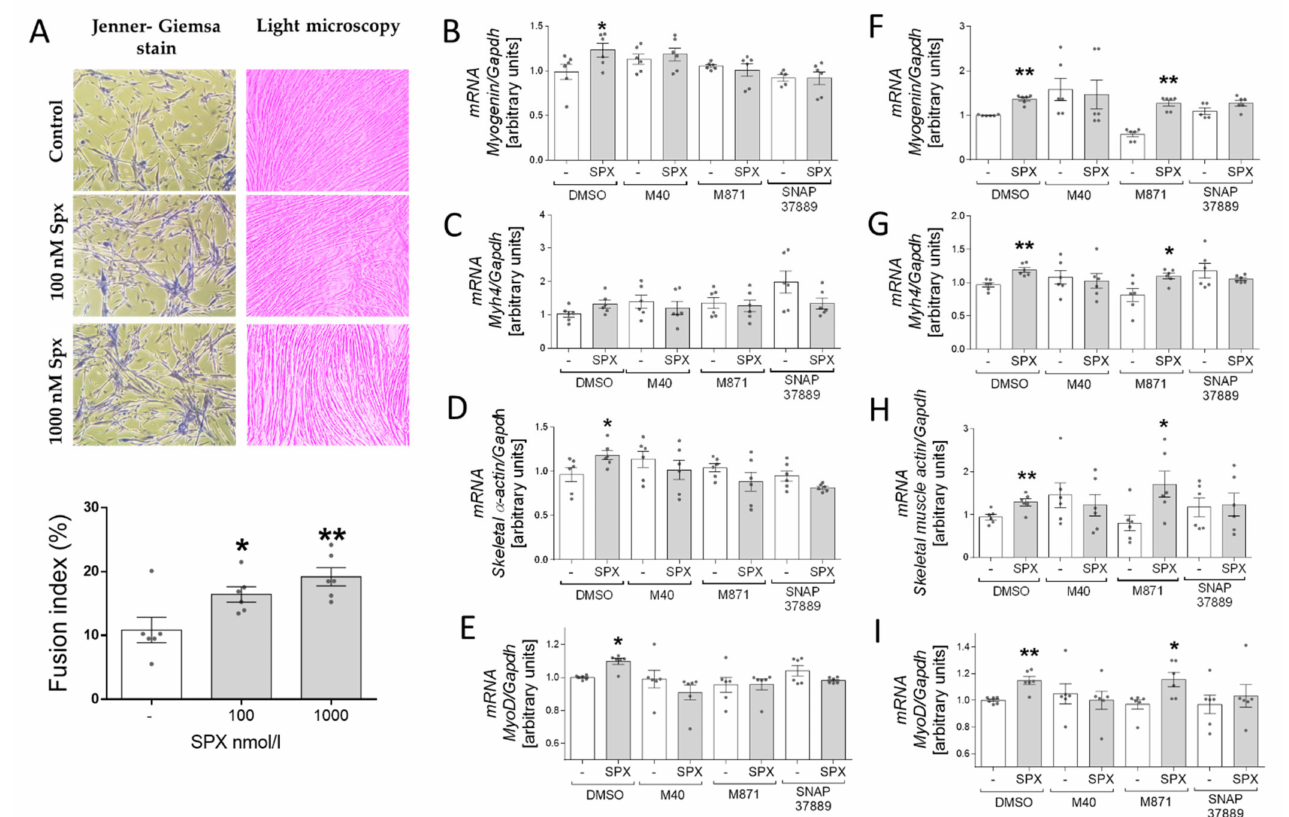
Figure 5. Fusion index changes after SPX treatment ( A ). The effect of SPX on myogenin ( B ), Myh4 ( C ), skeletal α -actin ( D ) and MyoD ( E ) mRNA expression after 2 days of differentiation in the presence of the absence of galanin receptor antagonists (M40—nonselective GalRs antagonist; M871—selective GalR2 antagonist; and SNAP 37889—selective GalR3 antagonist) and myogenin ( F ), Myh4 ( G ), skeletal α -actin ( H ) and MyoD ( I ) mRNA expression after 6 days of differentiation. Values are presented as mean ± standard error of the mean (S.E.M.) (( A ), n = 6; ( B – I ), n = 5–6). Statistically significant differences are marked for p < 0.05 (*) and p < 0.01 (**) compared to the corresponding